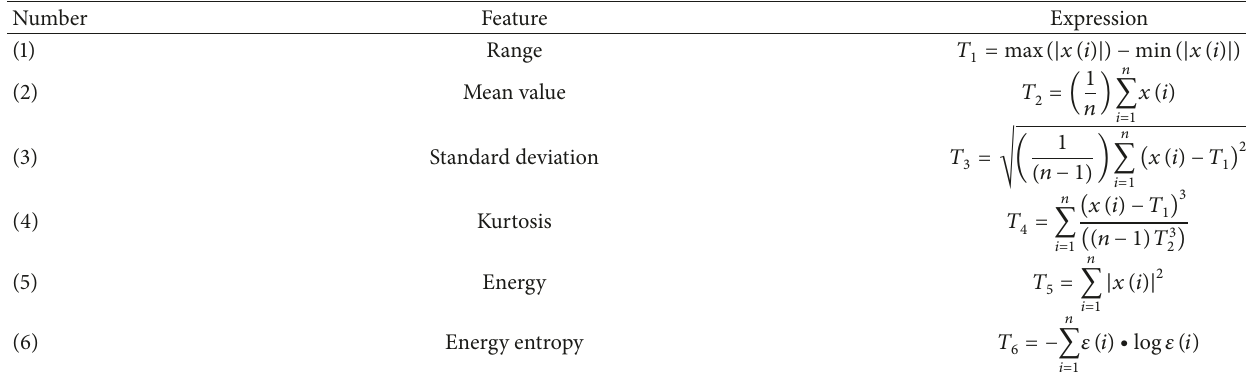
Table 2: Statistical parameters.